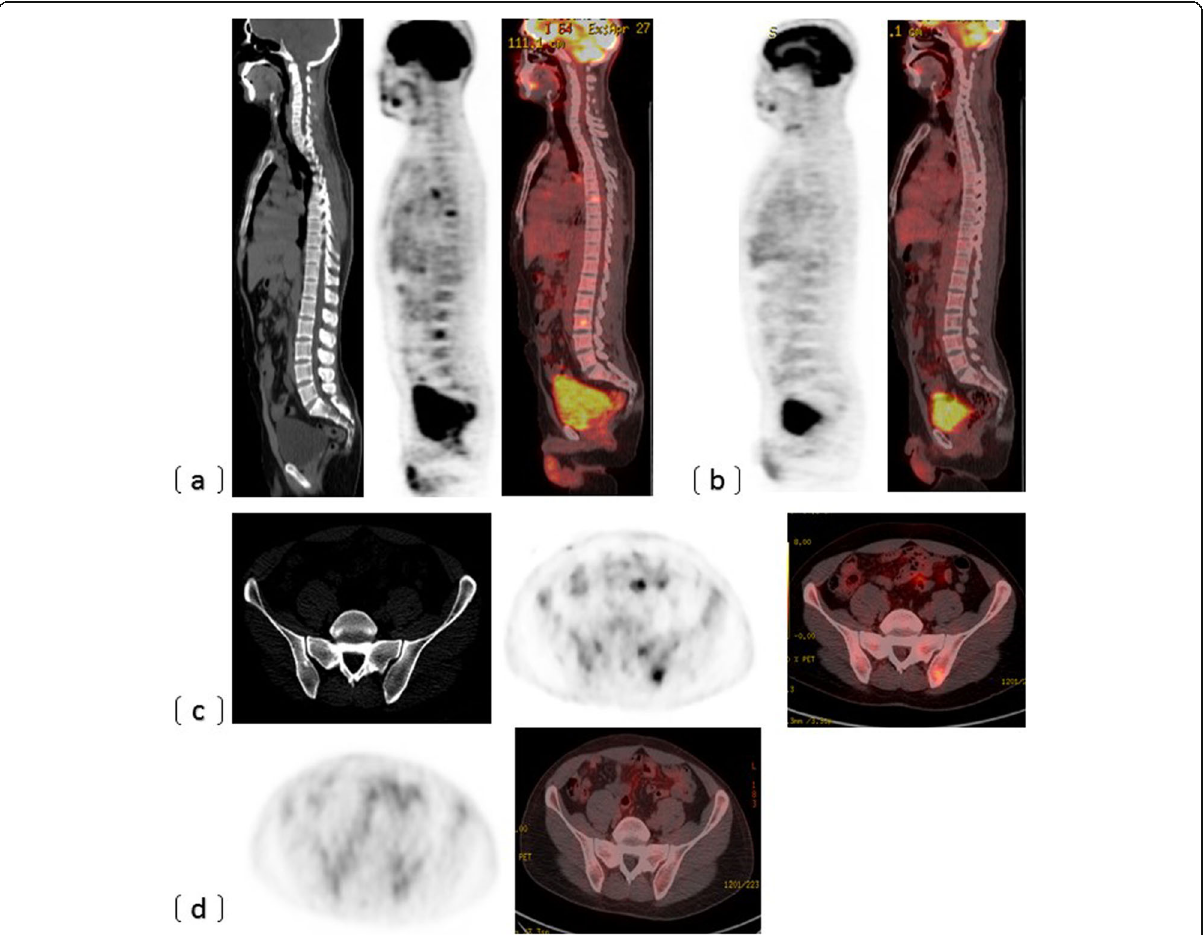
Fig. 9 A 37-year-old male patient with pathologically proven DLBCL ( a ) are initial CT image, PET image, and PET/CT fused images in the sagittal plane showing FGD uptake at the dorsal and lumbar spine with no corresponding CT changes. ( c ) Initial CT image, PET image, and PET/CT fused image in the axial planes showing uptake in left posterior iliac crest with no corresponding CT changes. ( b and d ) The post-treatment images showing complete resolution of the previous lesions. BMB was taken from the right posterior iliac crest, which is not involved and was negative